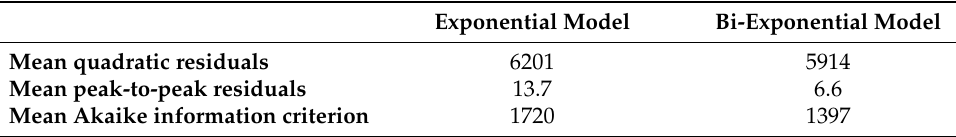
Table 1. Pulse models